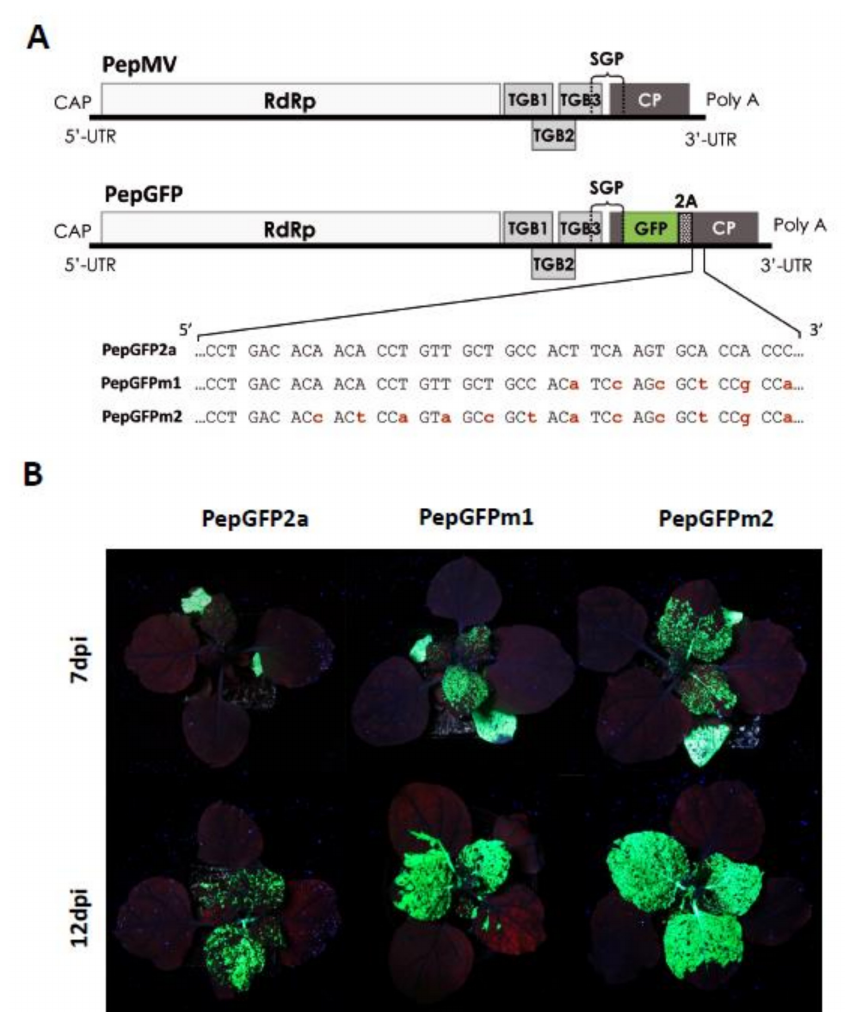
Figure 3. Pepino mosaic virus (PepMV) vectors expressing the green fluorescent protein (GFP). ( A ) Schematic representation (not to scale) of the PepMV genome and modified variants PepGFP2a, PepGFPm1, PepGFPm2, carrying the GFP gene. The GFP was expressed as a fusion to the coat protein (CP) through the foot and mouth disease virus 2A catalytic peptide sequence. The nucleotides marked in red correspond to synonymous mutations introduced into the corresponding vector versions to avoid sequence duplications. ( B ) Nicotiana benthamiana plants infected with PepMV vectors expressing GFP. Fluorescence was visualized in plants inoculated with PepGFP2a, PepGFPm1 or PepGFPm2 under UV light at 7 and 12 d post-inoculation (dpi). This figure is adapted with permission from